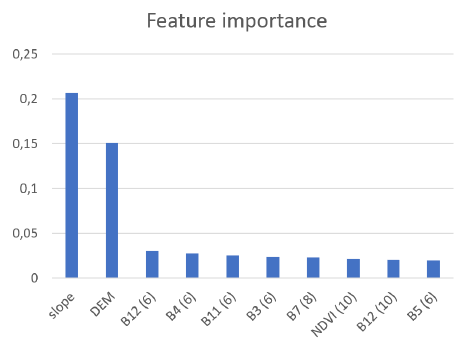
Figure 8. North Macedonia: Feature importance (top 10).